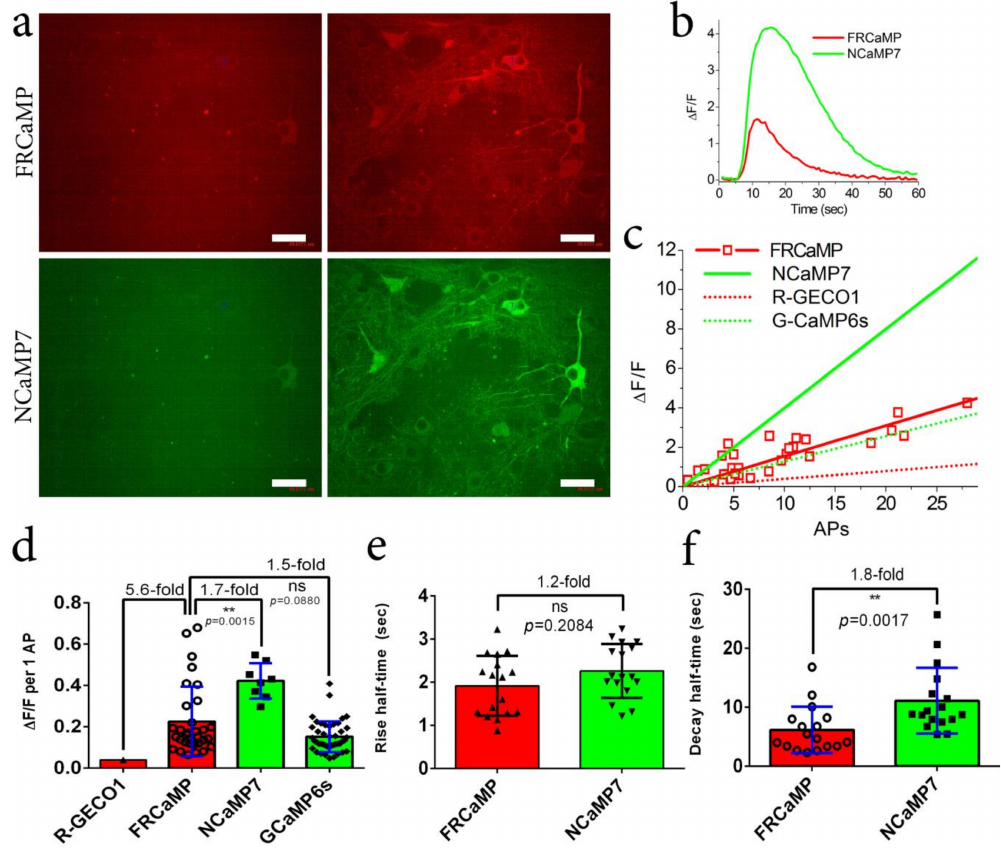
Figure 5. Comparison of the responses of red FRCaMP and green NCaMP7 indicators to the external field stimulation of neurons co-expressing the GECIs in dissociated neuronal cultures. Neuronal cultures co-expressing the NES-FRCaMP and NES-NCaMP7 indicators were imaged and stimulated on DIV 21–22th. Neuronal cultures were transduced on DIV fourth with a mixture of rAAVs carrying NES-FRCaMP and NES-NCaMP7. ( a ) Confocal images of neuronal culture co-expressing the NES-FRCaMP and NES-NCaMP7 indicators before (left) and after (right) electrical stimulation. Scale bar, 50 µ m. ( b ) The graph illustrates ∆ F/F changes in the red and green fluorescence of the FRCaMP and NCaMP7 indicators in response to an electrical field stimulation. The changes on the graph correspond to the area indicated on panel a as a numbered circle. ( c ) The dependence of ∆ F/F responses for the FRCaMP indicator vs. the number of action potentials (APs). A number of APs was determined according to the ∆ F/F response of the NCaMP7 indicator (0.4 per 1 AP [18]) co-expressed in the same cell and assuming that response’s linearity in the examined AP range (linear fitting for FRCaMP had R 2 value of 0.7006). The dependences of ∆ F/F responses on APs for R-GECO1 and G-CaMP6s were added to compare the results with previous work [3]. ( d ) The ∆ F/F response per one AP for FRCaMP was calculated according to the ∆ F/F response of NCaMP7 (0.4 per 1 AP [18]) in the same cell. For comparison, the ∆ F/F responses per one AP for R-GECO1 and G-CaMP6s were added from previous work [3]. ( e , f ) The rise ( e ) and decay ( f ) halftimes for FRCaMP and NCaMP7. ( d – f ) Error bars are the standard deviations across 17–32 cells. Ns, not significant. **, p -value is 0.001 to